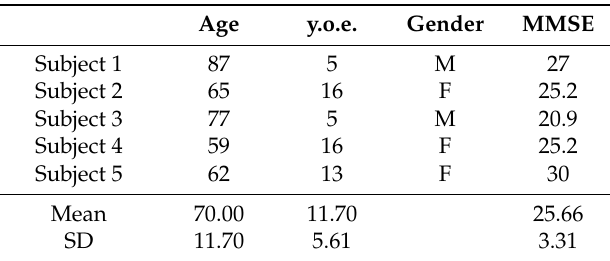
Table 2. Demographic data.